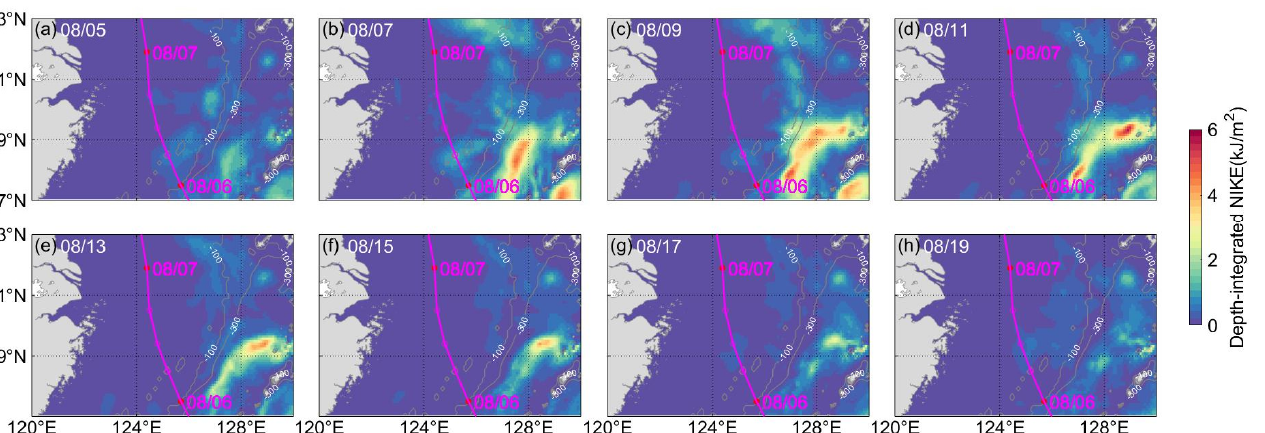
Figure 2. ( a , b ) Zonal and ( c , d ) meridional velocities of ( a , c ) raw HYCOM reanalysis data and ( b , d ) filtered NIWs as a function of time and depth. The vertical dashed line in each subfigure denotes the time when Muifa passed.